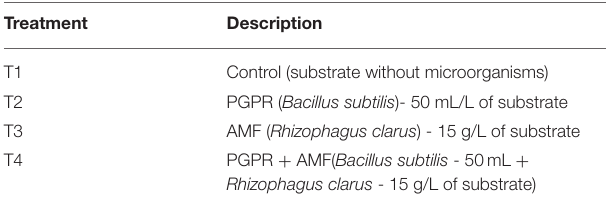
TABLE 1 | Treatments and doses used for incorporation into the substrate of microorganisms Rhizophagus clarus and Bacillus subtilis in the production of Tectona grandis